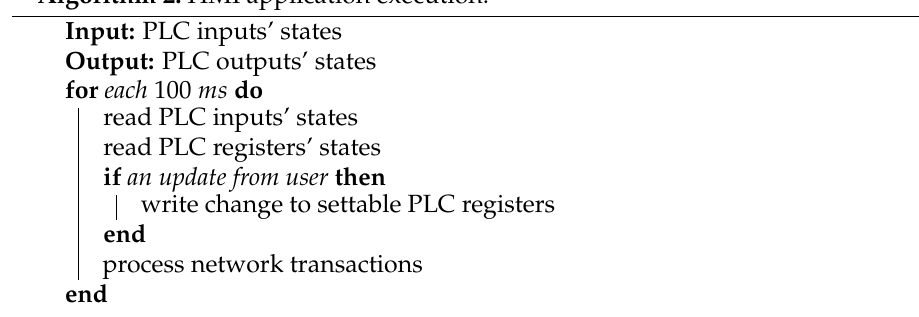
Algorithm 2: HMI application